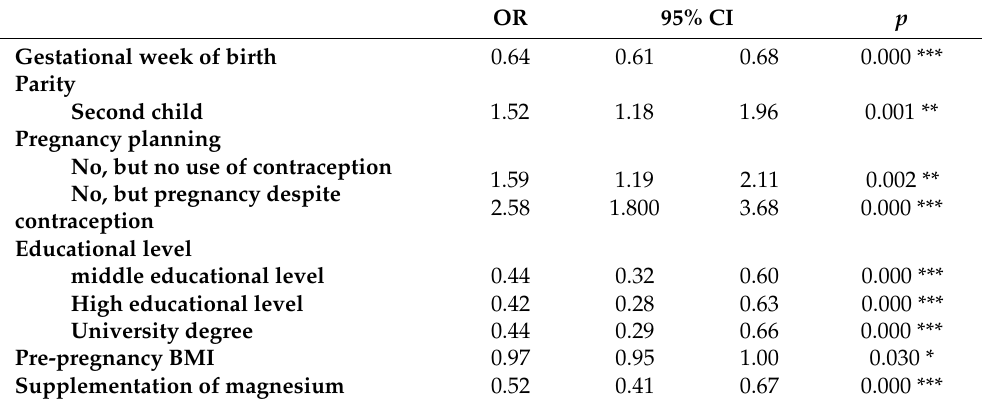
Table 5. Impact of selected maternal, pregnancy and health behavior factors on antenatal care behav- ior: multiple logistic regression analysis with antenatal care below standard as the dependent variable. OR 95% CI